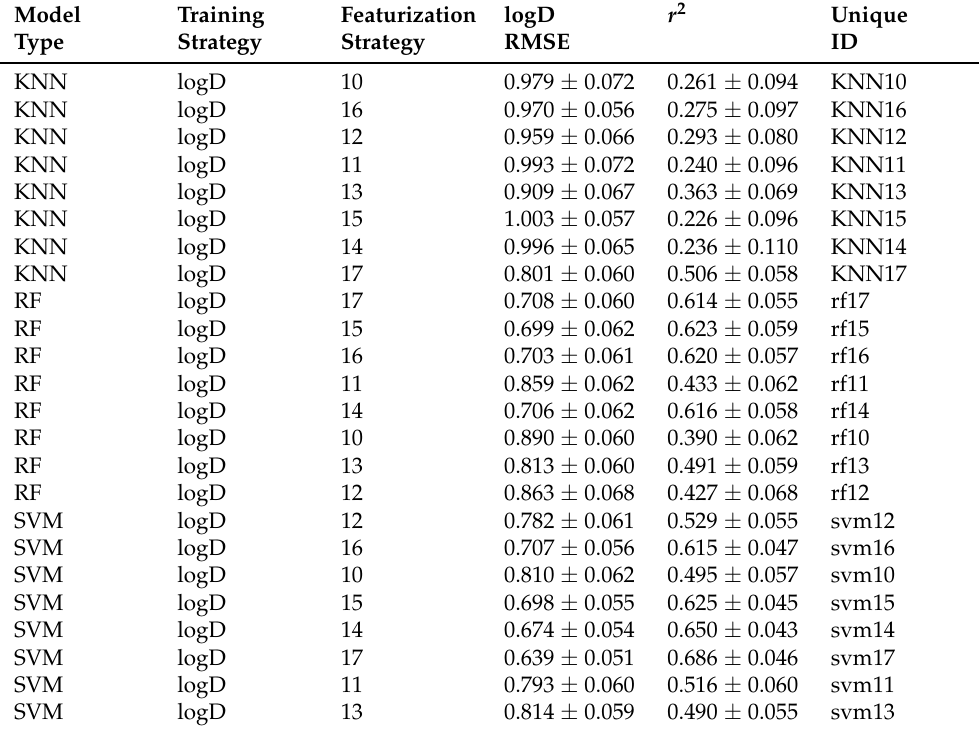
Table A11. Shows the logD RMSE and r 2 results for the non-GNN model types used during this survey. The last column consists of the unique identifier. Training strategy 0 represents a training strategy combining logD, logS, and logP, 1 represents a strategy combining logD and logP, 2 stands for a combination of logD and logS, 3 represents a strategy using logS and logP, 4 represents a strategy using logD, 5 represents a strategy using logS, and 6 represents a strategy using logP.